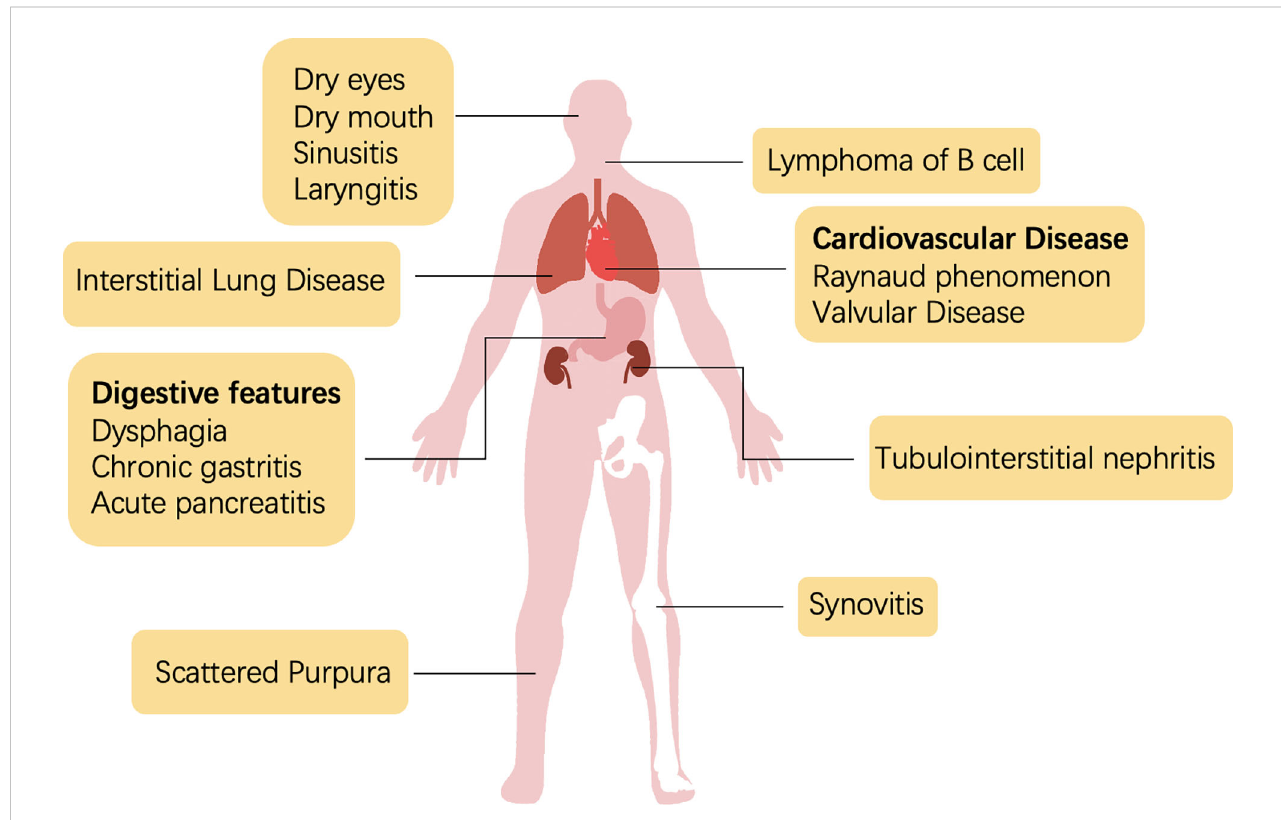
FIGURE 1 Typical glandular and extraglandular manifestations of